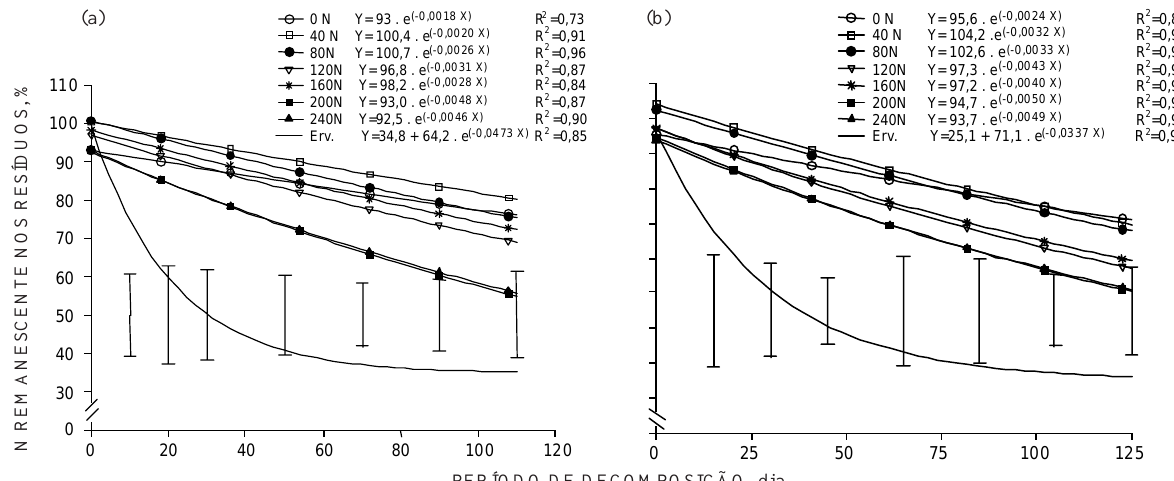
Figura 2. Liberação do N dos resíduos culturais da aveia preta e da ervilhaca no sistema plantio direto, avaliada por meio dos sacos de decomposição nos anos de 1998 (a) e 1999 (b). As barras verticais indicam a diferença mínima significativa (DMS) pelo teste Tukey a 5